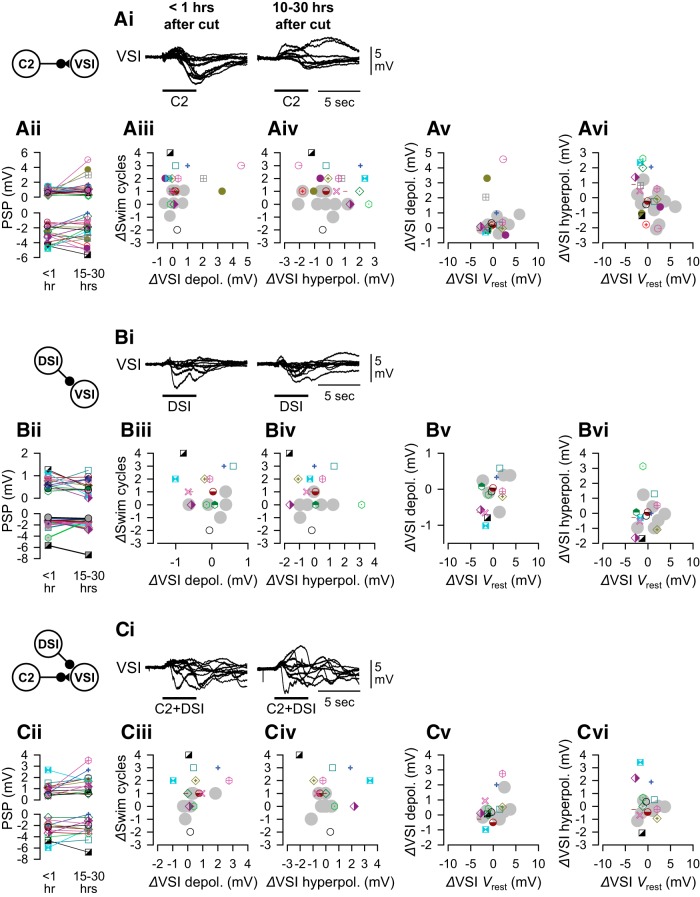
The direct synaptic actions of C2 and/or DSI onto VSI and their changes showed wide variations, but had little or no correlation with the changes in the number of swim cycles. All recordings were made in Hi-Di saline to minimize polysynaptic components. A, C2-evoked responses in VSI. Overlaid traces of C2-evoked synaptic responses in VSI (Ai) and plots of their amplitudes of evoked depolarization (Aii, top) and hyperpolarization (Aii, bottom) are shown. Recordings were made <1 h (left) and 10–30 h (right) after the disconnection. C2 was stimulated by injecting repetitive current pulses (20 ms in duration at 10 Hz for 4 s). No correlation was seen between changes in swim cycles (ΔSwim cycles) and the amplitudes of C2-evoked depolarization (ΔVSI depolarization by C2; p = 0.43 by linear regression, N = 18; Aiii) or C2-evoked hyperpolarization (Δhyperpolarization by C2; p = 0.44 by linear regression, N = 18; Aiv). The change in the resting potential of VSI showed no correlation with C2-evoked depolarization (Av) or hyperpolarization (Avi). B, DSI-evoked synaptic responses in VSI. Overlaid traces of DSI-evoked responses (Bi) and plots of their amplitudes (Bii) at two different times were shown. No correlation was seen between changes in swim cycles and DSI-to-VSI synaptic action (Biii and Biv; p = 0.99 and 0.57 by linear regression, N = 13). The change in the resting potential of VSI showed no correlation with DSI-evoked depolarization (Bv) or hyperpolarization (Bvi). C, Synaptic response of VSI to the combined C2+DSI stimulation. Overlaid traces of the responses (Ci) and plots of their amplitudes (Cii) at two different times were shown. No correlation was seen between changes in swim cycles and the synaptic actions (Ciii and Civ; p = 0.51 and 0.57 by linear regression, N = 13). The change in the resting potential of VSI showed no correlation with C2+DSI-evoked depolarization (Cv) or hyperpolarization (Cvi). Gray circles represent control data with no PdN6 disconnection. In Ai, Bi, and Ci, overlaid traces from 10 representative preparations were shifted to align at the onset of the synaptic potential.